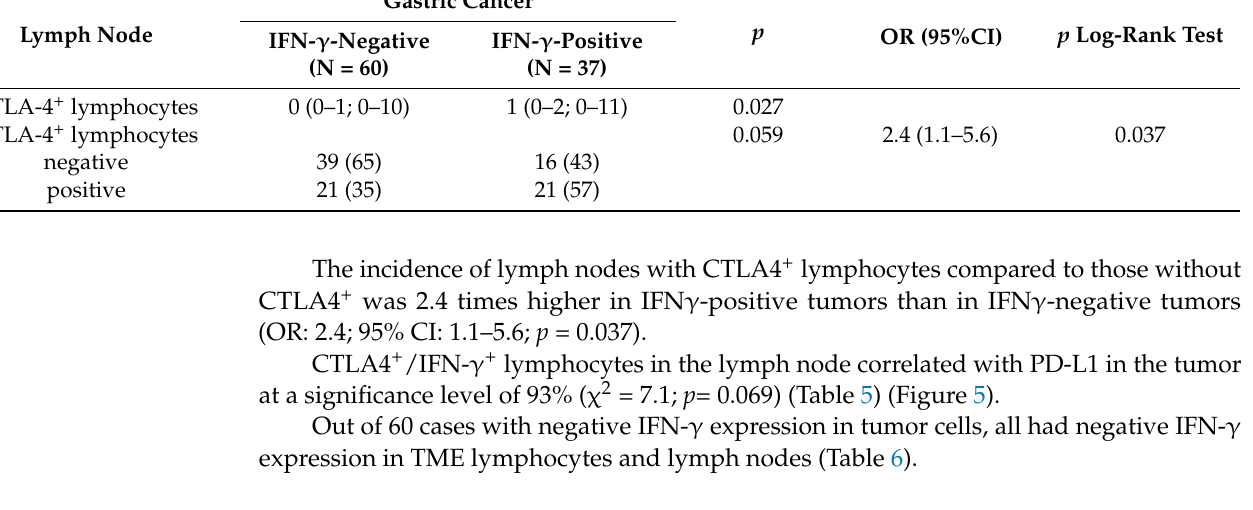
Table 5. The correlation of the CTLA-4/IFN- γ lymphocytes with the PD-L1 status of GC. Area CTLA-4/IFN-